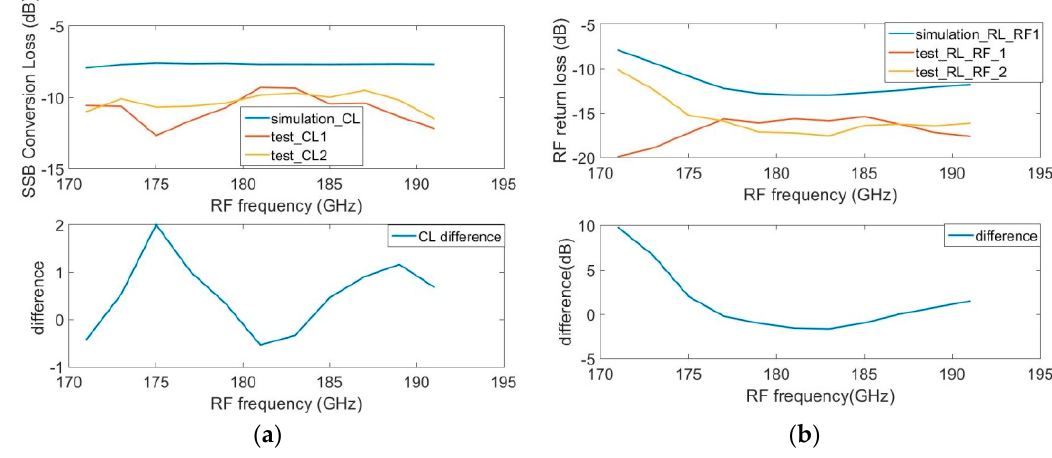
Figure 15. ( a ) Conversion loss test results of mixer 2. ( b ) RF return loss test results of mixer 2.